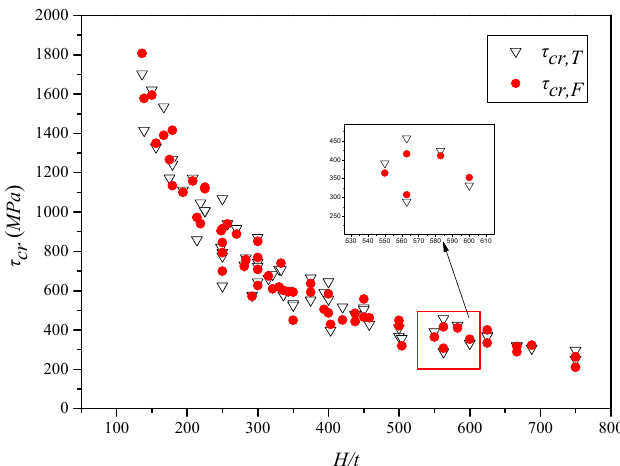
Figure 7. Global elastic shear buckling strength τ cr versus web height-to-thickness ratio H / t ( R = 110 m).